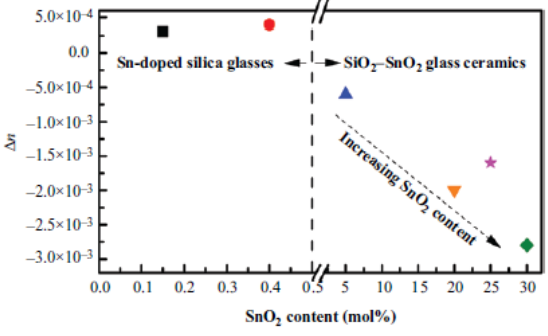
Fig. 2. The refractive index change under UV irradiation of the sol–gel derived tin-dioxide-based glass-ceramics and the tin-doped silica glasses as a function of SnO 2 content[18].